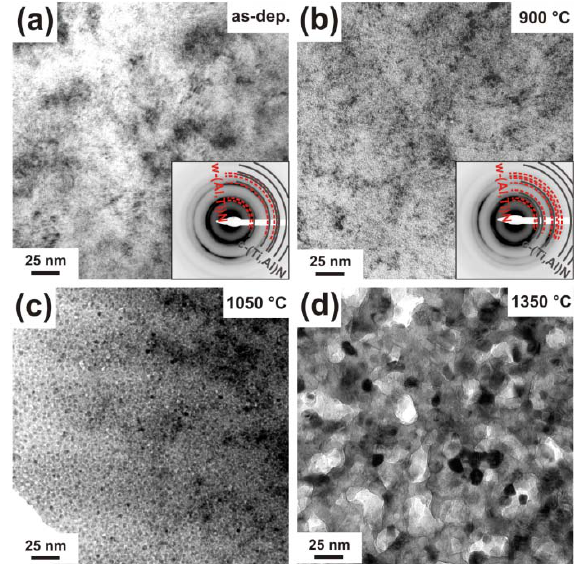
Figure 11. Plan view TEM micrographs of w-Ti and after annealing at (b) 900 °C, (c) 1050 °C, and (d) 1350 °C. The small insets in (a) and (b) are the corresponding SAED